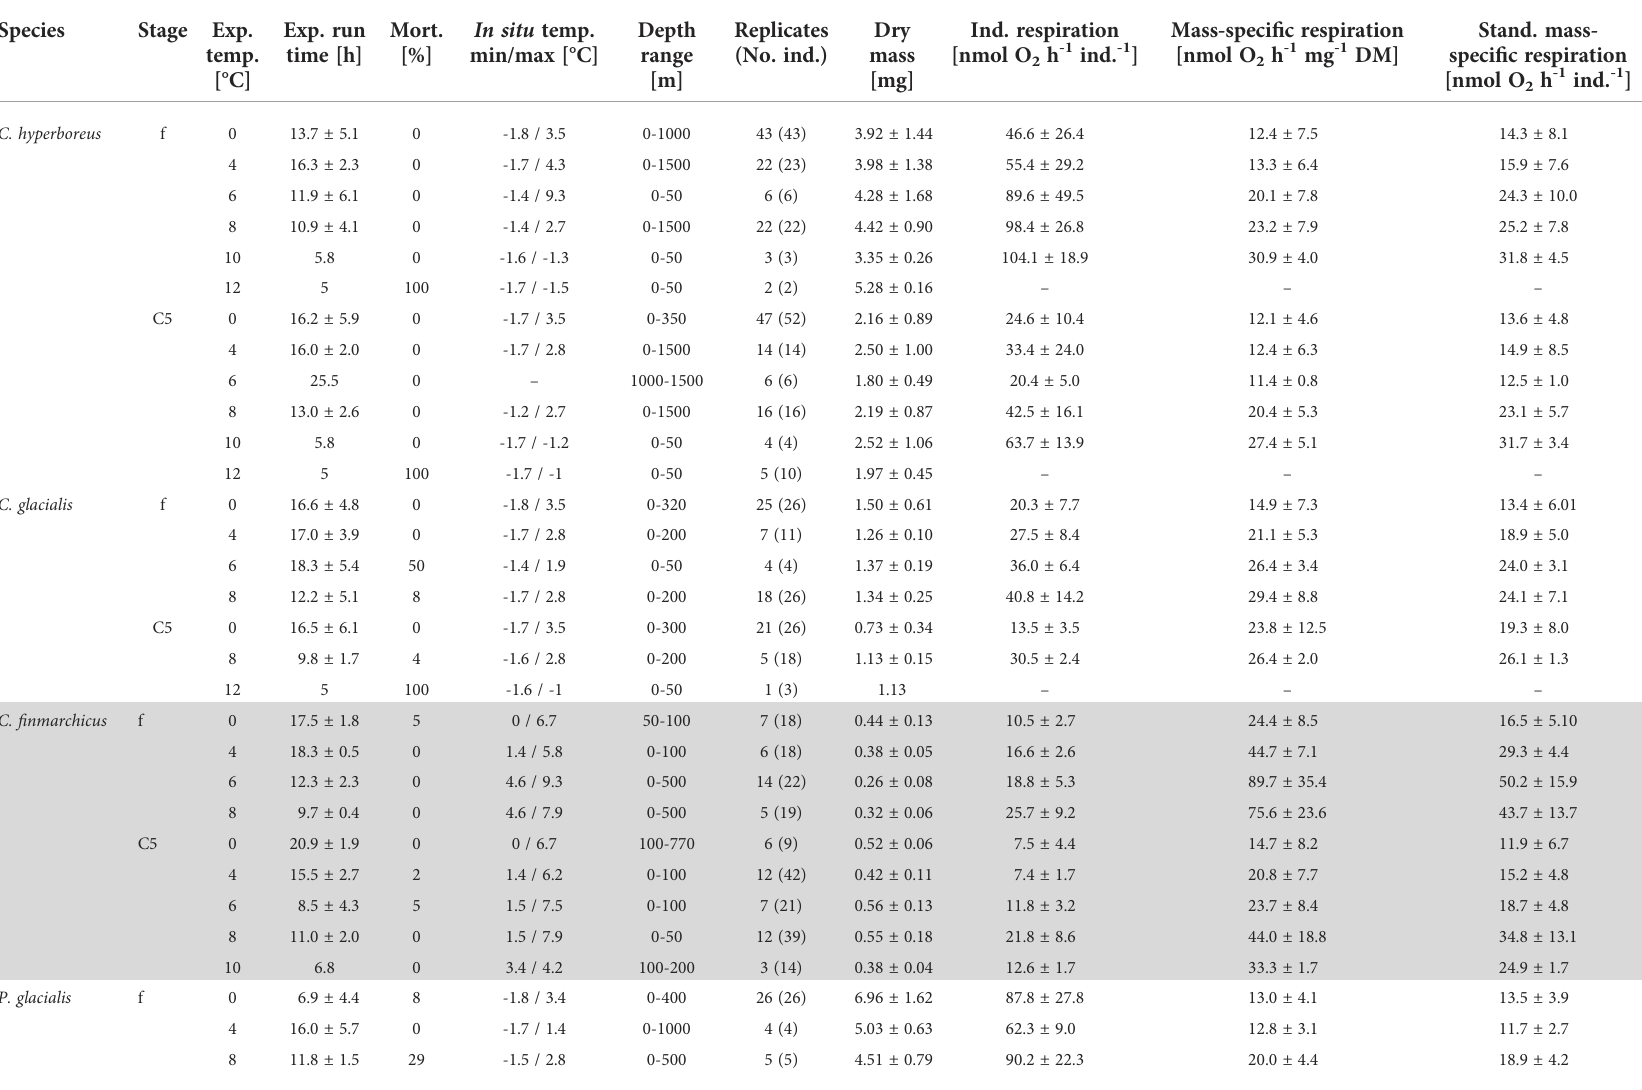
TABLE 1 Individual, mass-speci fi c and standardized mass-speci fi c respiration rates of polar-Arctic and boreal-Atlantic (grey highlighted) zooplankton species measured at different ambient temperatures (Exp. temp.) during three expeditions PS100 (2016), PS107 (2017) and PS121 (2019) with RV Polarstern to Arctic Fram Strait in summer (July-September). Species Stage Exp.